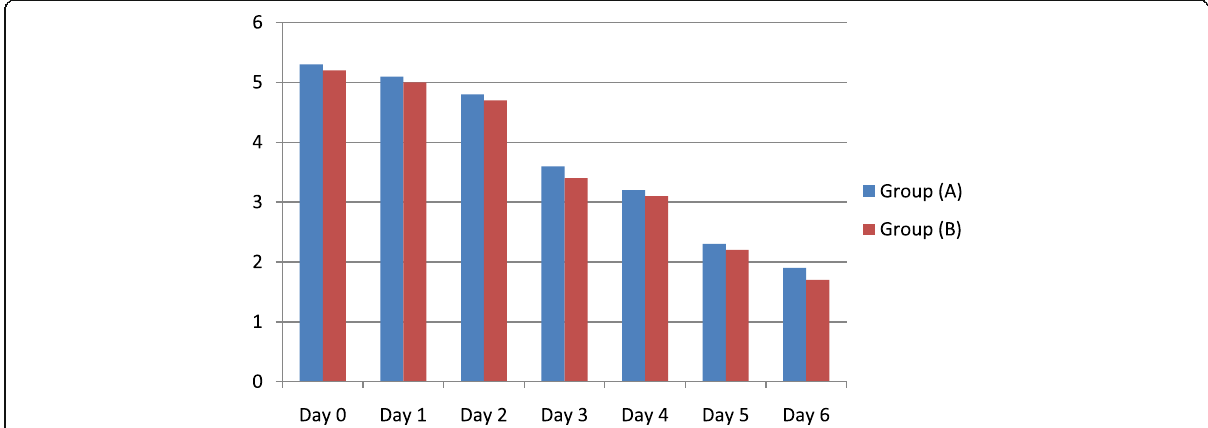
Fig. 4 Bar chart showing the comparison between group A (control) and group B (esmolol) according to ScvO2 %